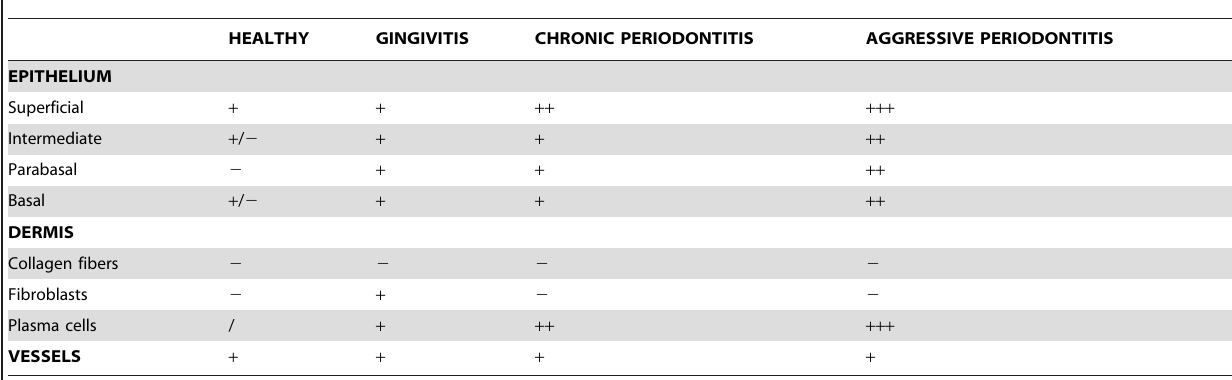
Table 3. Immunohistochemical staining for HtrA1 in studied